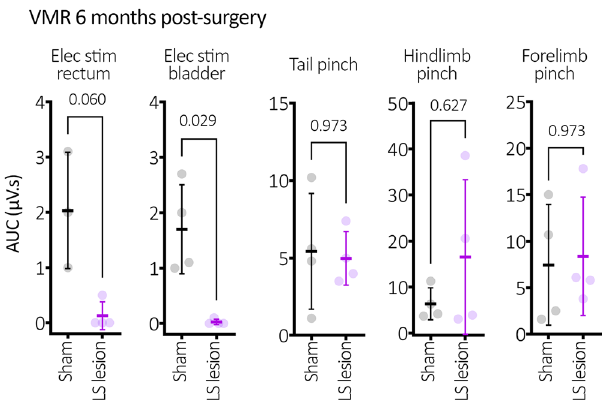
Fig. 6 Long-term abolition of the visceromotor re fl ex. Visceral insensitivity was maintained up to 6 months after surgery among LS lesioned mice, which showed a complete abolition of VMR to rectal and bladder electrical stimulation compared to sham mice. Tail and limb VMR responses showed no differences. P values refer to independent samples t tests (two-tailed). Statistically, there was no difference in VMR ( P = 0.060) for rectal stimulation, while there was a signi fi cant ( P = 0.029) for bladder stimulation. The lack of signi fi cance for rectal stimulation is likely attributable to the variability in sham EMG values, since VMRs were absent from rectum in DRG-removed mice. All error bars represent mean ± SD, individual markers represent individual animal